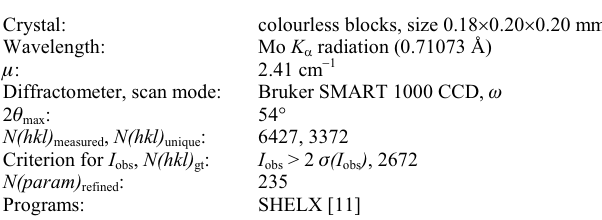
Table 1. Data collection and handling.